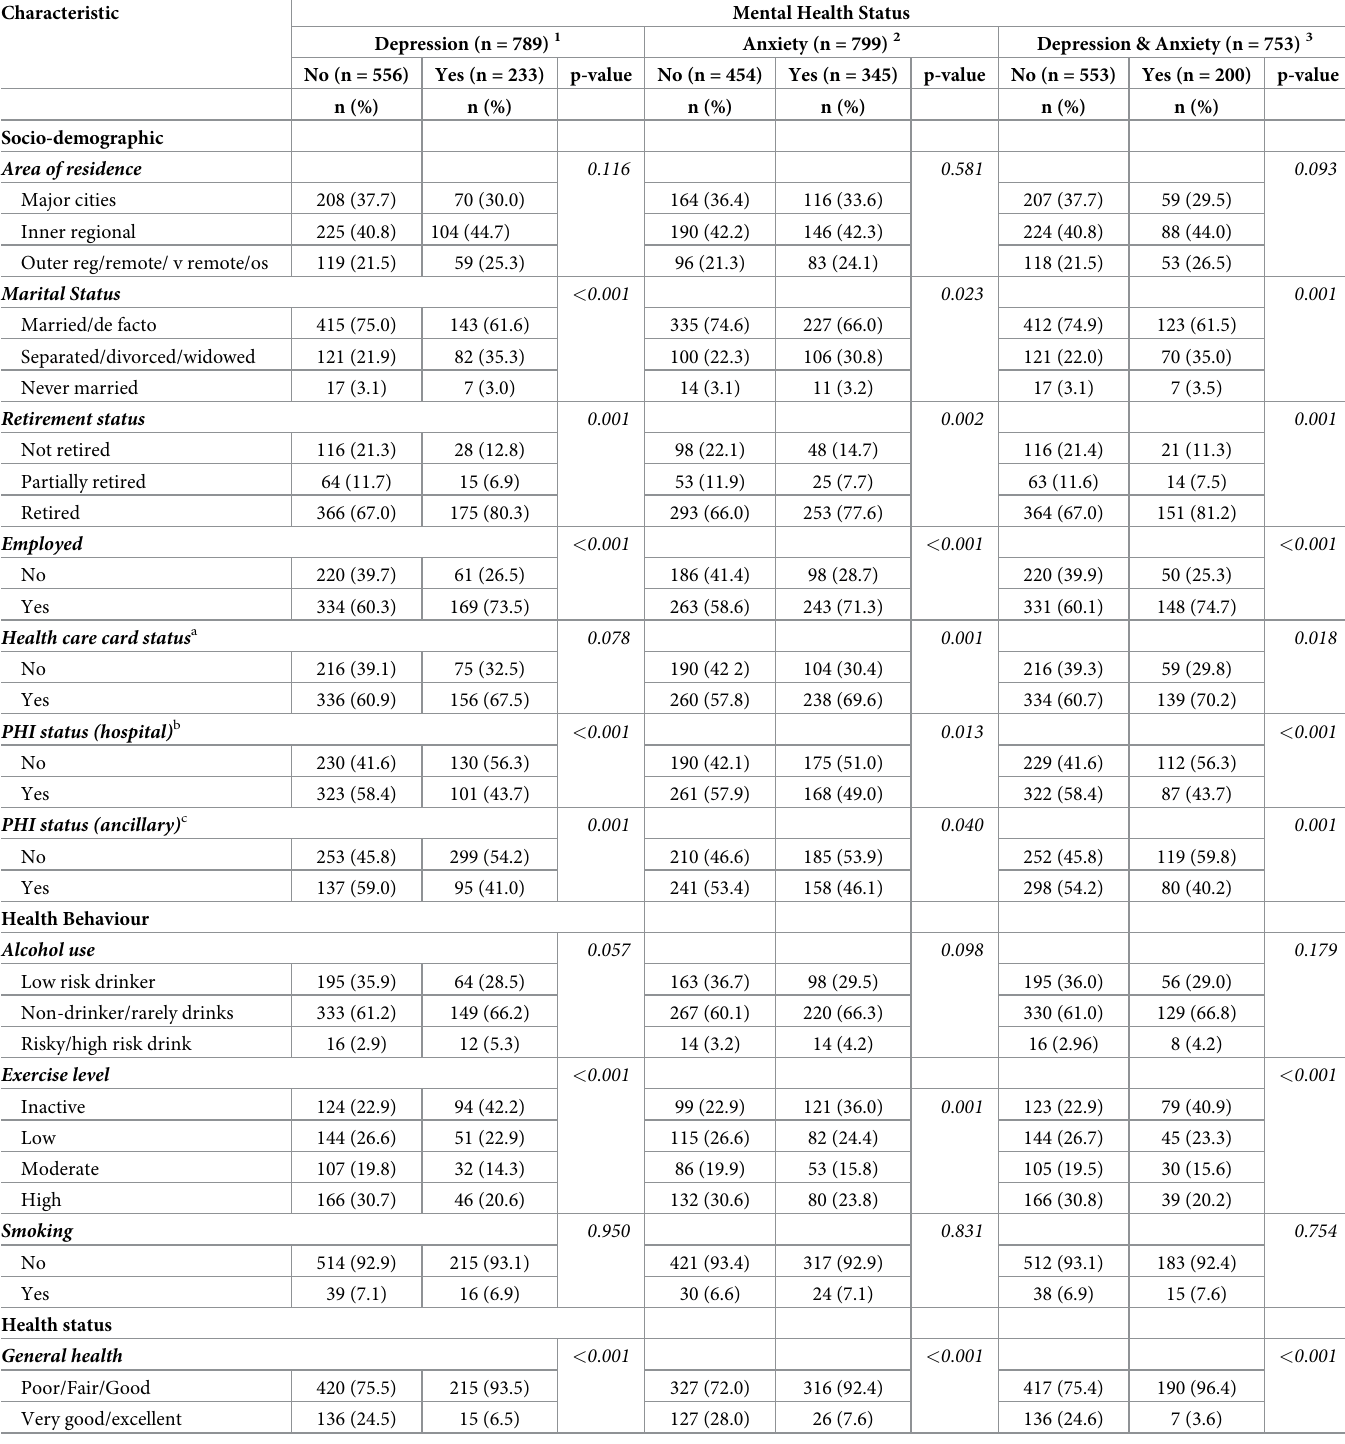
Table 2. Socio-demographic, health behaviour and health status characteristics of women with diabetes mellitus by mental health status.